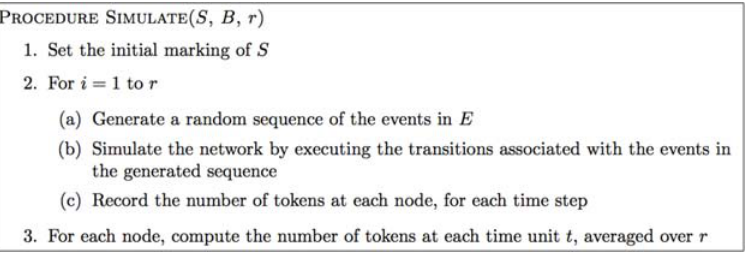
Figure 2. A High-Level Outline of the Procedure for Simulating a Signaling Network. The input to the procedure is a signaling Petri net, S, the number of time units to simulate the network for, B, and the number of runs for which to repeat the simulation, r. The random generation of event ordering is employed to simulate the stochasticity in reaction rates and the differing times of signal arrivals.